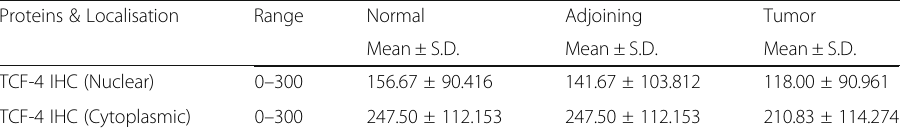
Table 3 Immunohistochemical scores for TCF-4 protein in tumor, adjoining and normal mucosa of